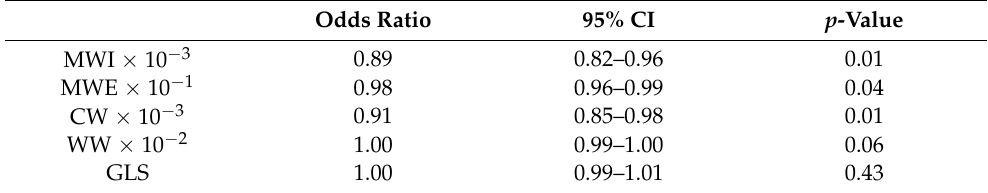
Table 4. Univariate random effect logistic regression model for Myocardial. Work indices and